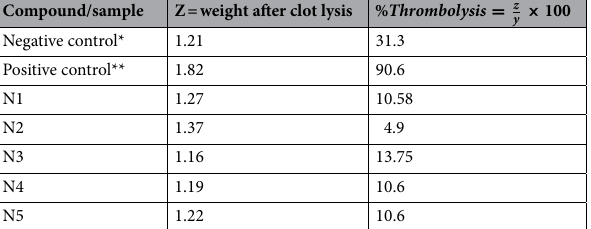
Table 5. Percentages of thrombolytic activity of five acrylonitrile adducts. Weight of clot before lysis (y) = 2.15 g, dis. *DMSO, **Streptokinase